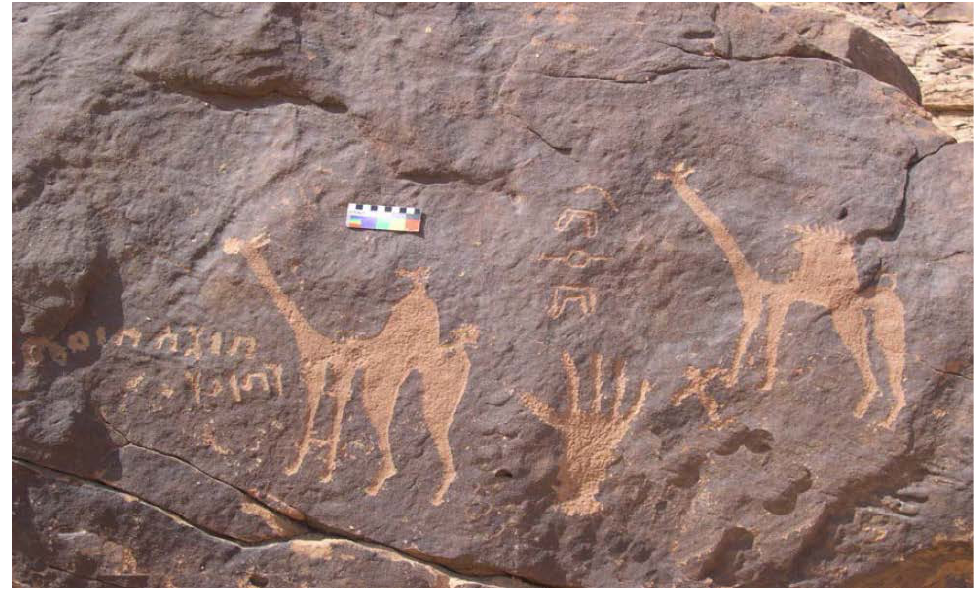
Figure 25. The camel has always been the most valuable desert animal. Its images are found in almost all parts of the country, often associated with Bedouin inscriptions and/or tribal symbols (such as the cross), as in this composition, indicating the name of the camel’s owner.